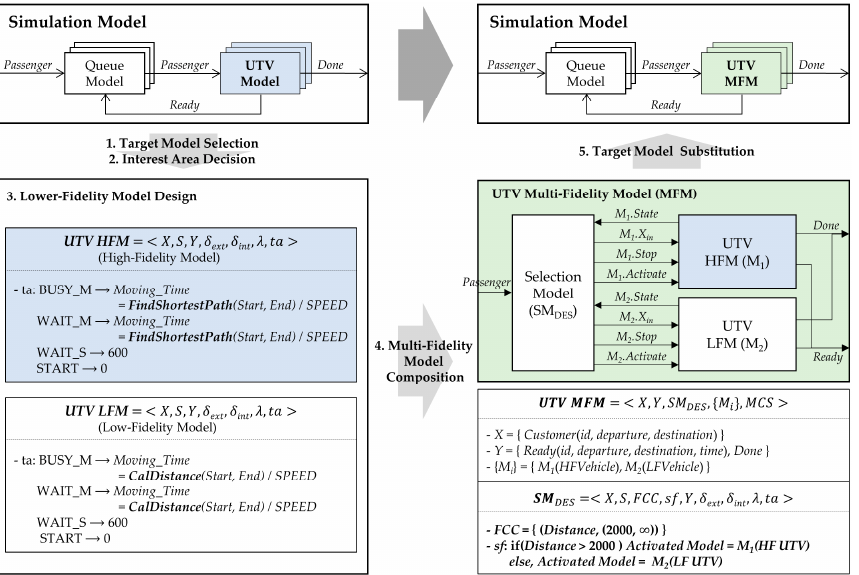
Figure 17. Overall process of the multi-fidelity modeling framework: UTV simulation as an example of the discrete event system.